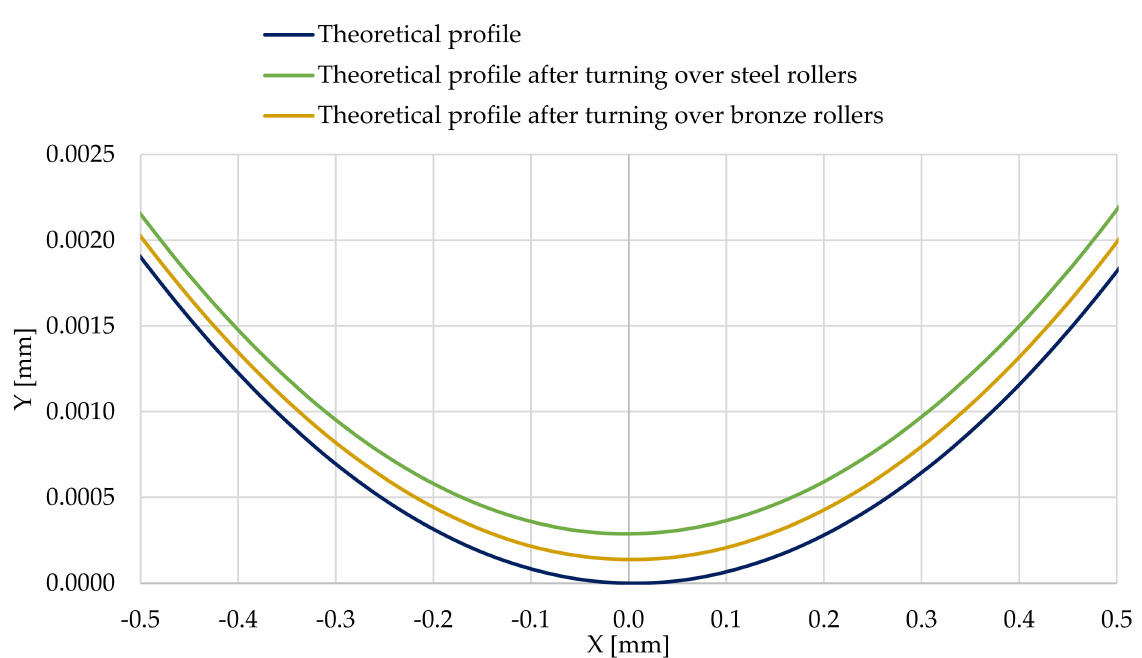
Figure 13. Comparison of the profile of the steel shaft journal, which is not burdened with outline irregularities, with the profiles after the outline has turned over the steel support roller and the support roller made of aluminum–bronze. In the case of a shaft journal with an irregular outline, the actual profile of journal No. 10 was selected for the analyses of permanent stresses and deformations. The actual mea- sured profile of journal No. 10 was recorded during 1024 measurements with equidistant points located on its circumference. The detailed procedure and description of the SAJD measurement system can be found in [30]. The SAJD measurement system is shown in Figure 14.